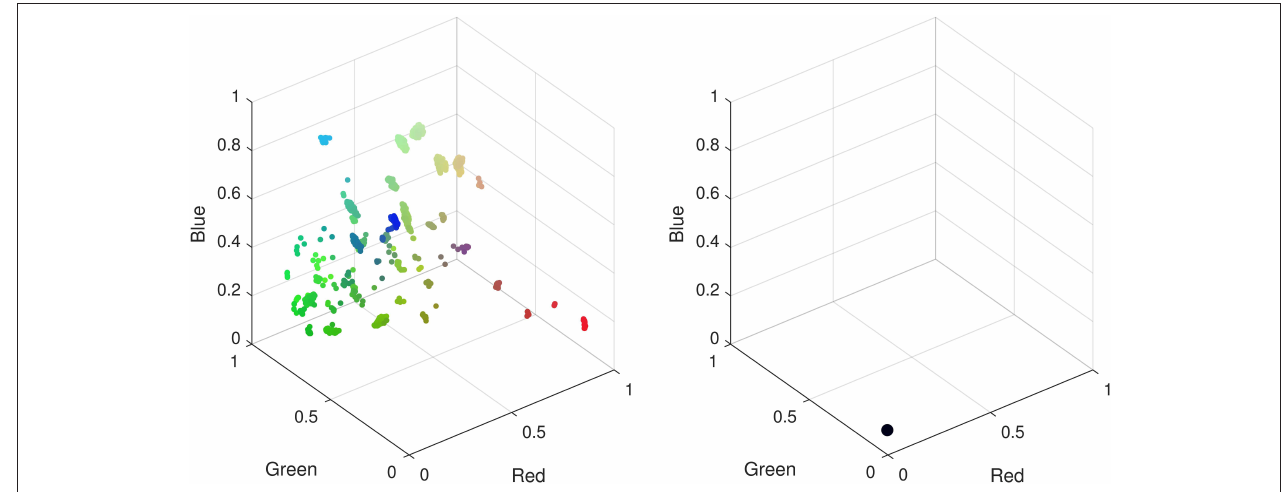
FIGURE 4 | Low dimensional representations of CMR data with a deep autoencoder using sigmoid (Left) and ReLU (Right) activation functions. Using a sigmoid activation function patterns identified by the network manifest as clusters in the low dimensional space. When using a ReLU function all data points are confined to the same low dimensional space hence there are no observable patterns to differentiate the CMR